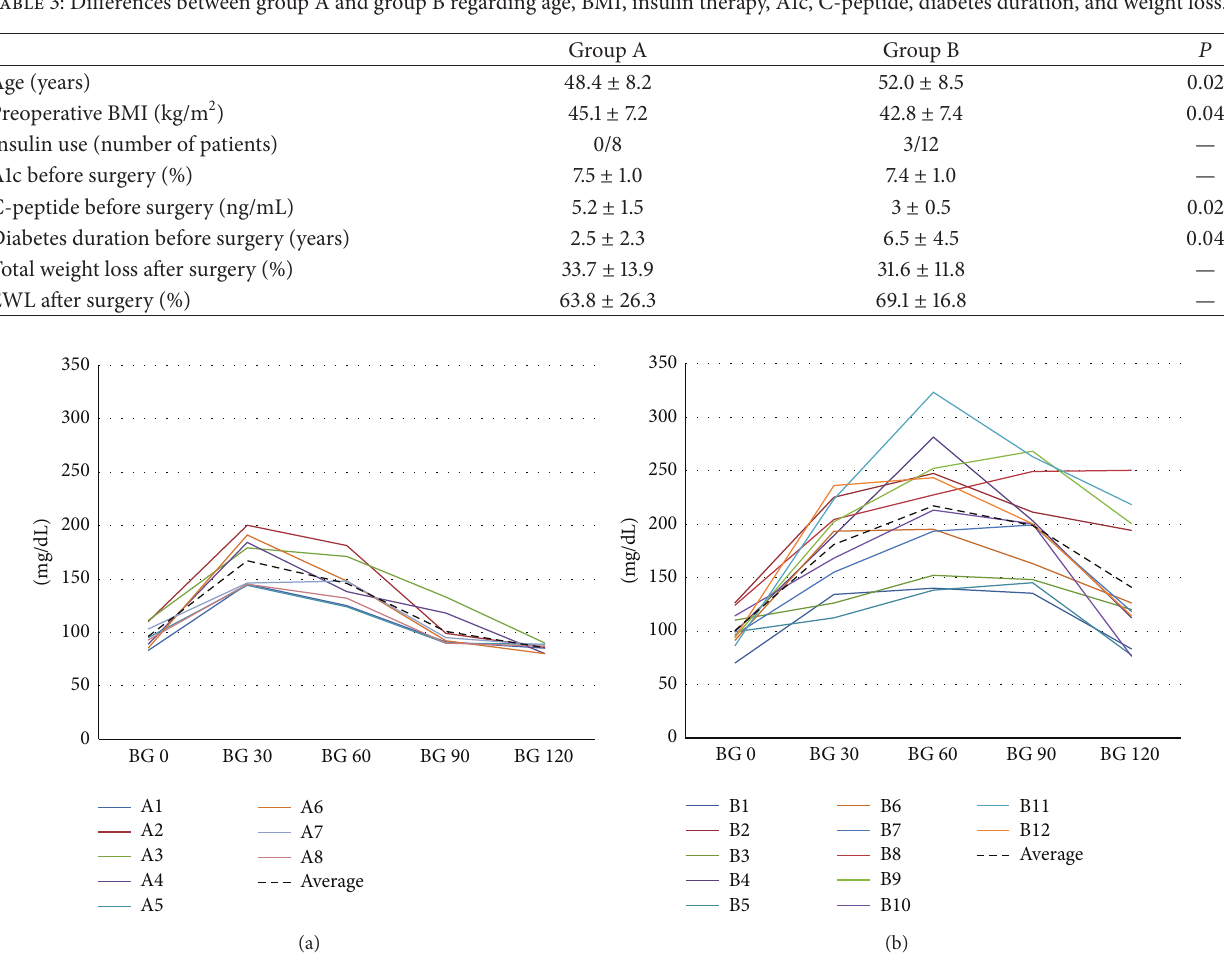
Figure 2: Glycemia during 2 h OGTT in each patient of group A (a) and group B